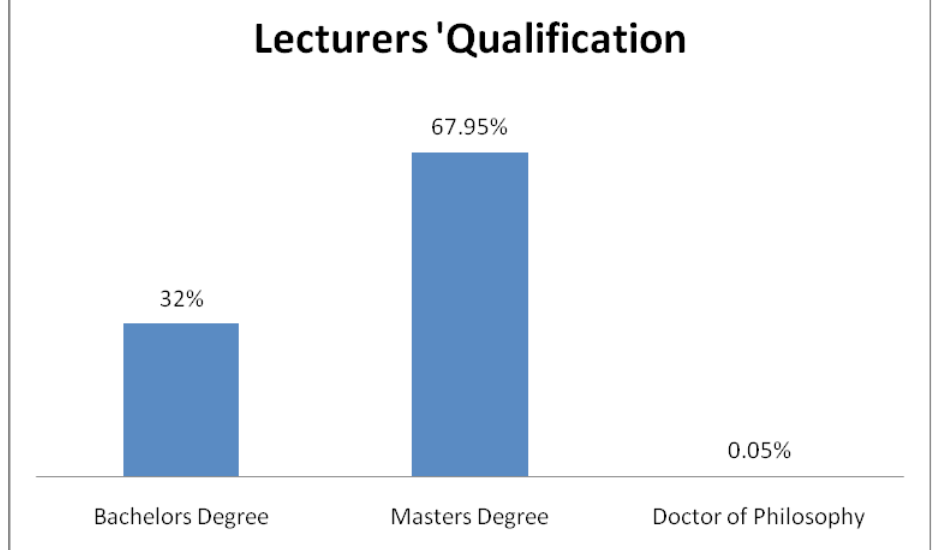
Figure 1 . Showing lecturers’ qualifications.